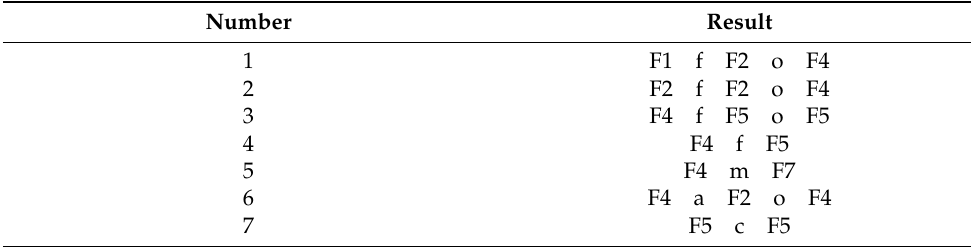
Table 4. Part of Mining